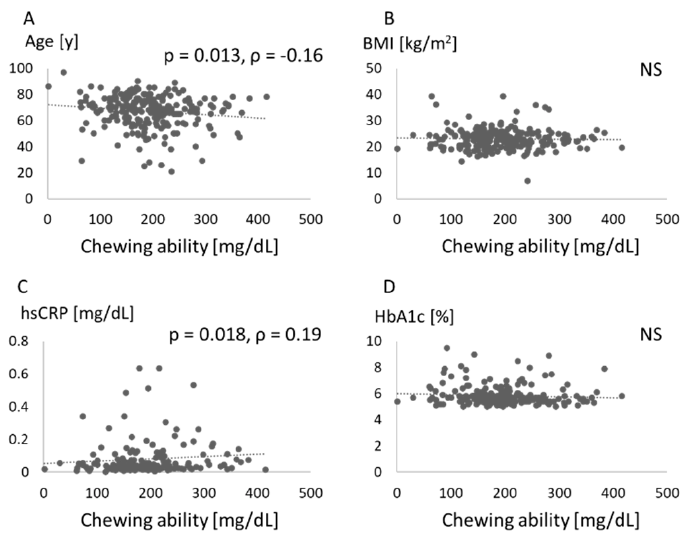
Figure 3. Association between each score and chewing ability. Age ( A ), body mass index (BMI) ( B ), high-sensitivity C-reactive protein (hsCRP) ( C ), and hemoglobin (Hb)A1c ( D ) are compared with number of teeth. NS: not significant.